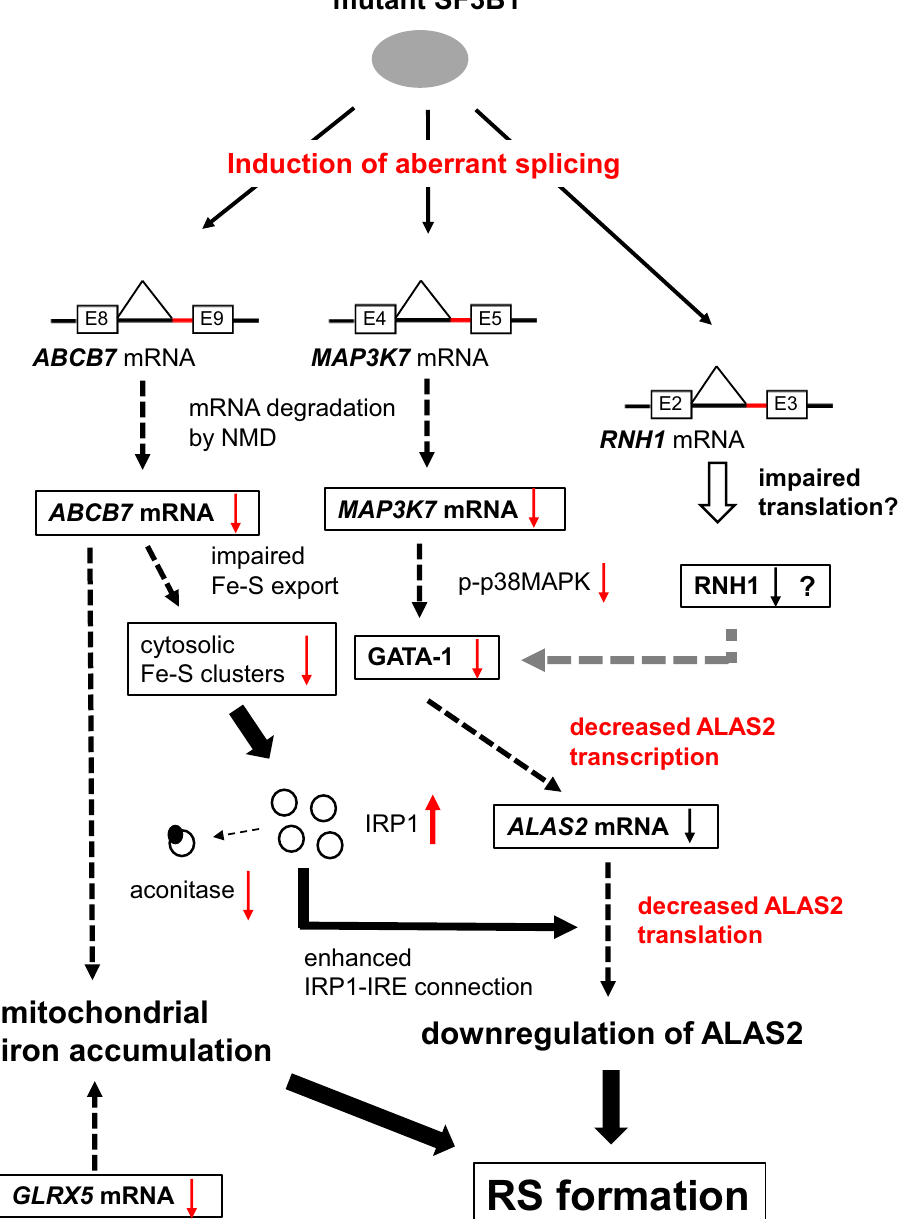
Figure 8. Proposed mechanism for RS formation in SF3B1 MUT -MDS. A3SS usage in ABCB7 , MAP3K7 , and RNH1 is promoted by the spliceosome containing the mutant SF3B1. Targeting of increased mis-spliced ABCB7 mRNA by NMD contributes to the downregulation of ABCB7, resulting in reduced translation of ALAS2 through an enhanced IRP1-IRE system induced by reduced cytosolic Fe–S cluster. Increased mis-spliced MAP3K7 mRNA, also targeted by NMD, contributes to the downregulation of MAP3K7, causing deterioration of GATA-1 function through the reduction in phosphorylated p38MAPK, as previously described 31 . Mis- splicing in the 5 ′ UTR of RNH1 might impair translation of RNH1, leading to downregulation of RNH1, which was reported to downregulate GATA-1 by inhibition of translation 42 . Thus, transcription of ALAS2 is reduced owing to decreased GATA-1 function induced by downregulation of MAP3K7, and perhaps RNH1. In conclusion, downregulation of ALAS2 at both the transcriptional and translational levels because of mutant SF3B1-induced mis-splicing in ABCB7 , MAP3K7 , and possibly RNH1 could be considered the underlying mechanism of RS formation in SF3B1 MUT -MDS. Moreover, downregulation of ABCB7 and GLRX5 also promoted RS formation by accelerating mitochondrial iron accumulation through decreased Fe–S cluster export from the mitochondria and decreased production of Fe–S cluster, resulting in decreased use of mitochondrial free iron. p-p38MAPK indicates phosphorylated